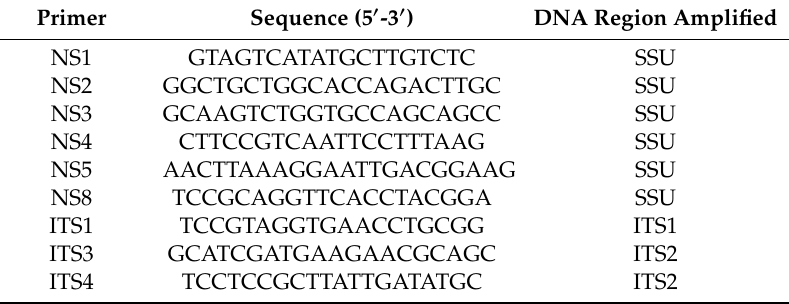
Table 1. Primers used in this